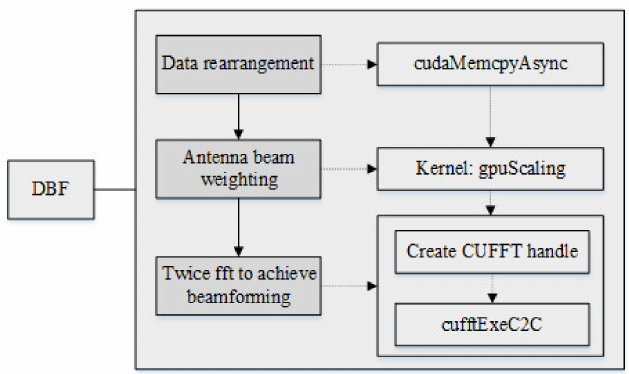
Figure 8. Block diagram of the beamforming